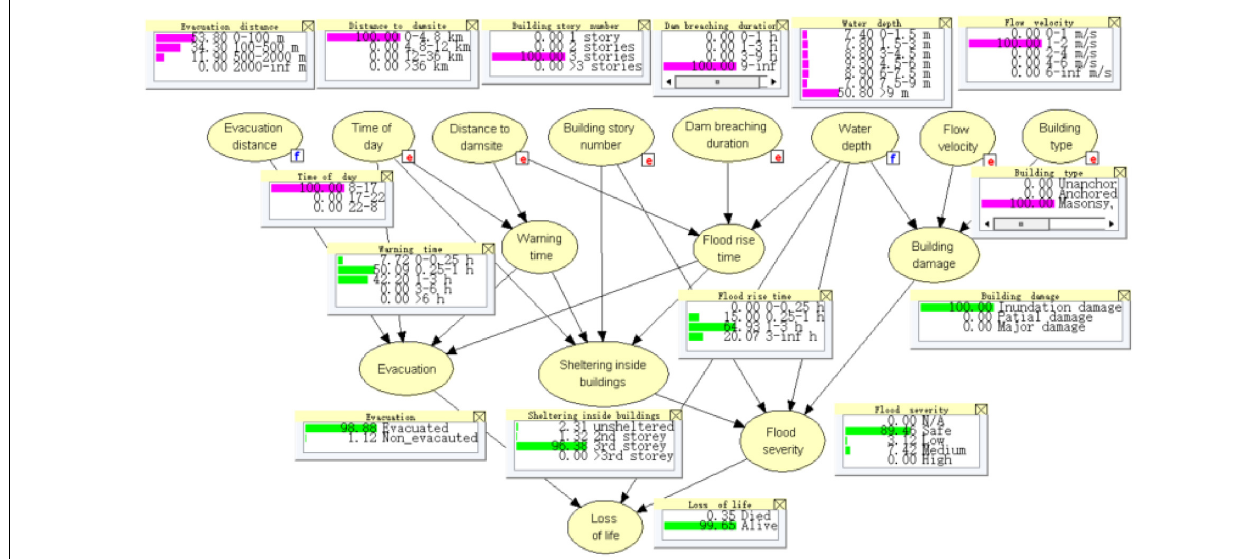
FIGURE 2 | Risk assessment of Scenario 4 in Beichuan County.